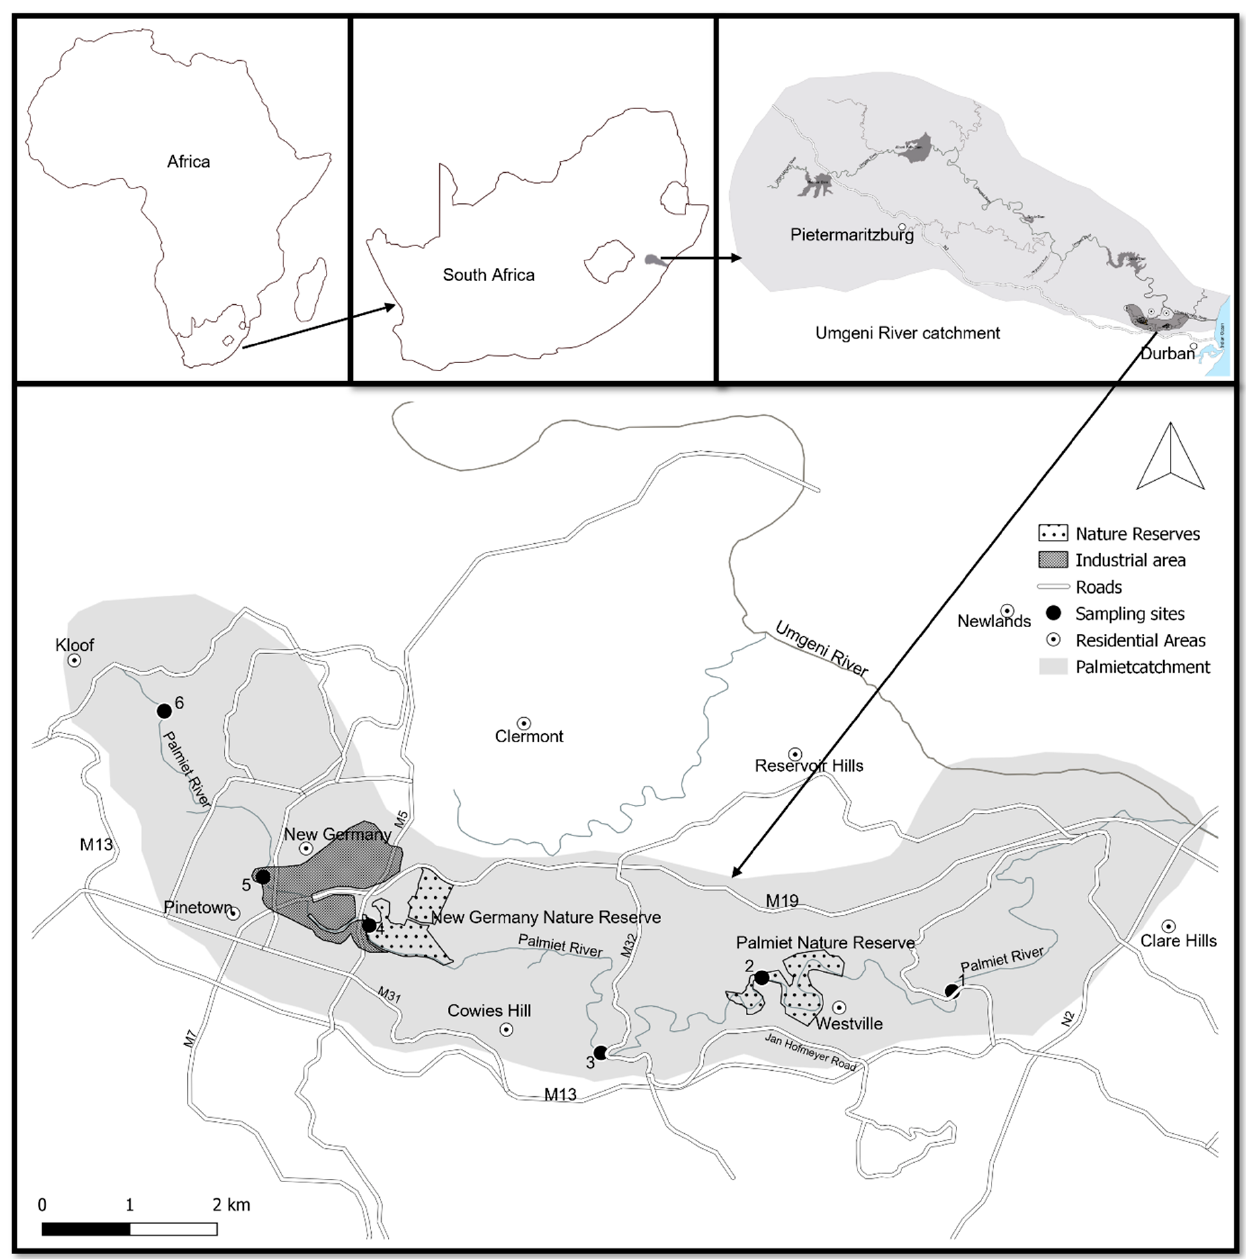
Figure 1. The Palmiet River catchment with sampling sites represented by black dots.